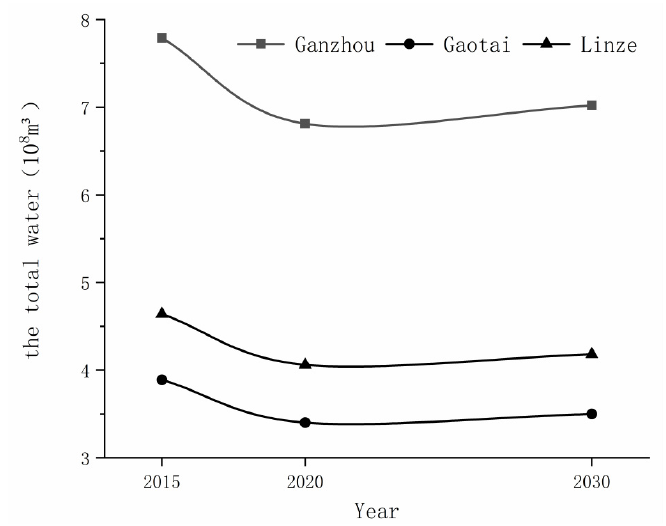
Figure 4. Total water consumption